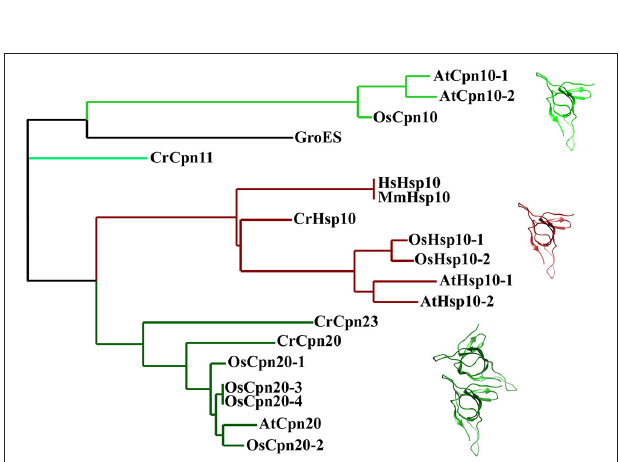
FIGURE 4 | Phylogenetic relationships of co-chaperonin proteins from bacteria, chloroplasts and mitochondria. The tree was generated using Phylogeny (http://www.phylogeny.fr/). Protein sequences of E. coli , H. sapiens , and M. musculus chaperonin are from UniProt database Protein sequence of plant mitochondria and chloroplast co-chaperonins are from Phytozome, TA Protein sequences of mitochondria chaperonin are from IR and RGAP [AtHsp10-1 (AT1G14980), AtHsp10-2 (AT1G23100), CrHsp10 (Cre03.g178450), OsHsp10-1(Os03g25050), OsHsp10-2 (Os07g44740), CrCpn11 (Cre16.g673729), CrCpn20 (Cre08.g358562), CrCpn23 (Cre12.g505850), AtCpn10-1 (At3g60210), AtCpn10-2 (At2g44650), AtCpn20 (At5g20720), OsCpn10 (Os10g41710), OsCpn20-1 (Os02g54060), OsCpn20-2 (Os09g26730), OsCpn20-3 (Os06g09679), OsCpn20-4 (Os06g09688)]. The molecular structure was generated by UCSF Chimera (Pettersen et al., 2004) using GroES coordinates 1AON from Protein Data